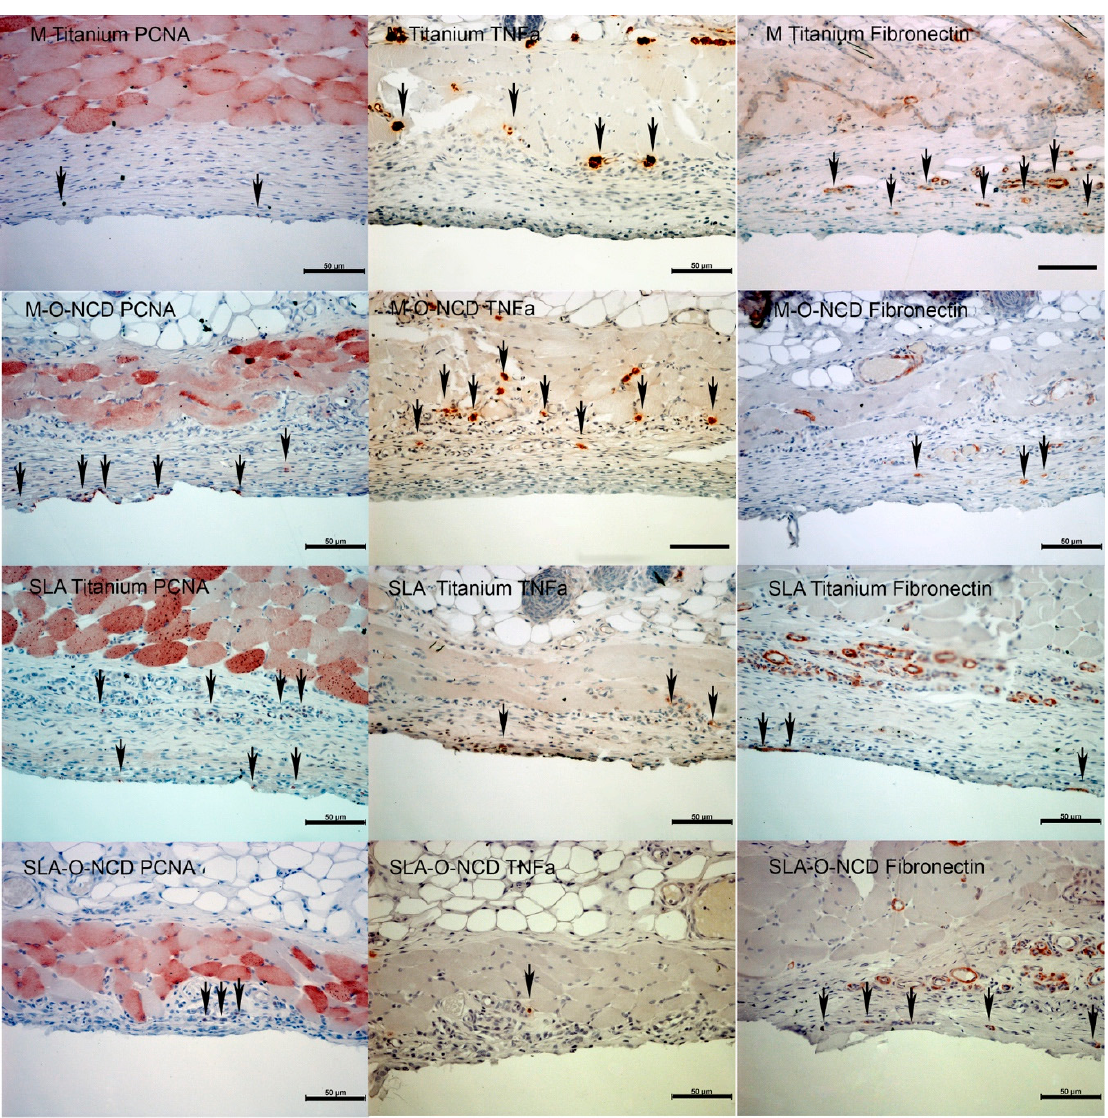
Figure 4. Immunohistochemistry after 1 week. PCNA showed proliferating cells in all samples, especially on the hydrophilic machined surface. The inflammatory protein TNFa was found near the SLA Titanium surface and not near hydrophilic layers. In deeper layers, TNFa expression was seen in all samples, serving as staining control. Fibronectin was mainly expressed on the rough hydrophilic surface. As fibronectin is usually found in vessels, these signals served as staining control. Scale bars indicate 50 µm.